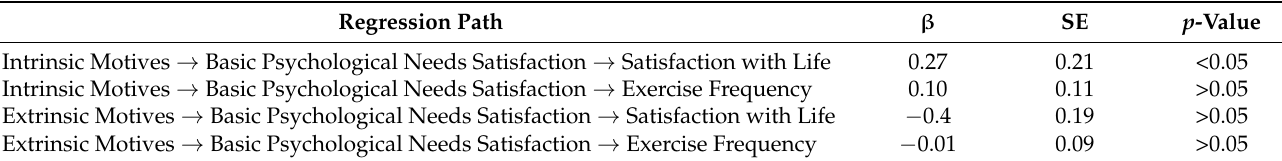
Figure 1. Structural equation model. Notes: Standardized coefficients are reported; within brackets = 95% confidence interval. Table 2. Indirect regression